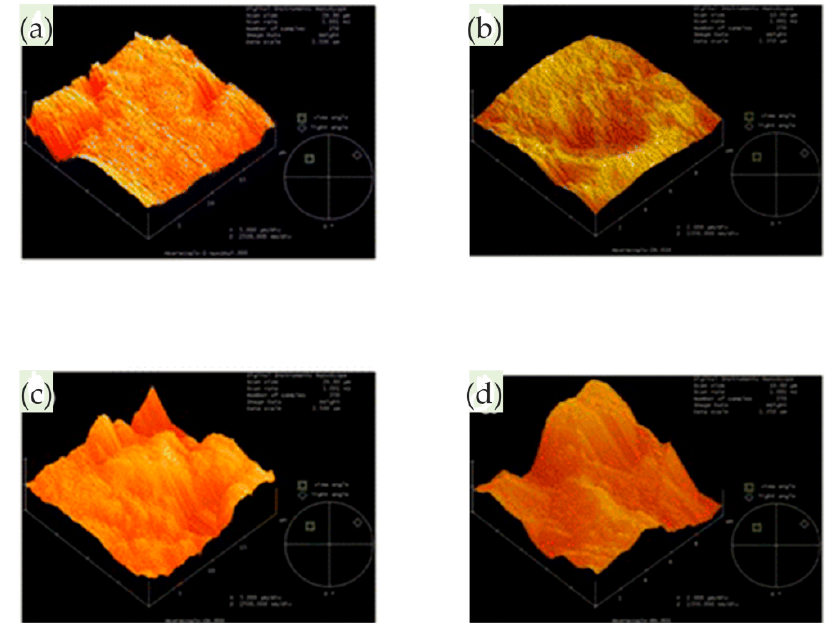
Figure 16. AFM images recorded for Zn in 0.5 M NaOH solution containing 0.05 M ( a , b ) ClO 4 − or ( c , d ) ClO 3 − . Adapted with permission from Reference [51]; copyright 2013 Springer.